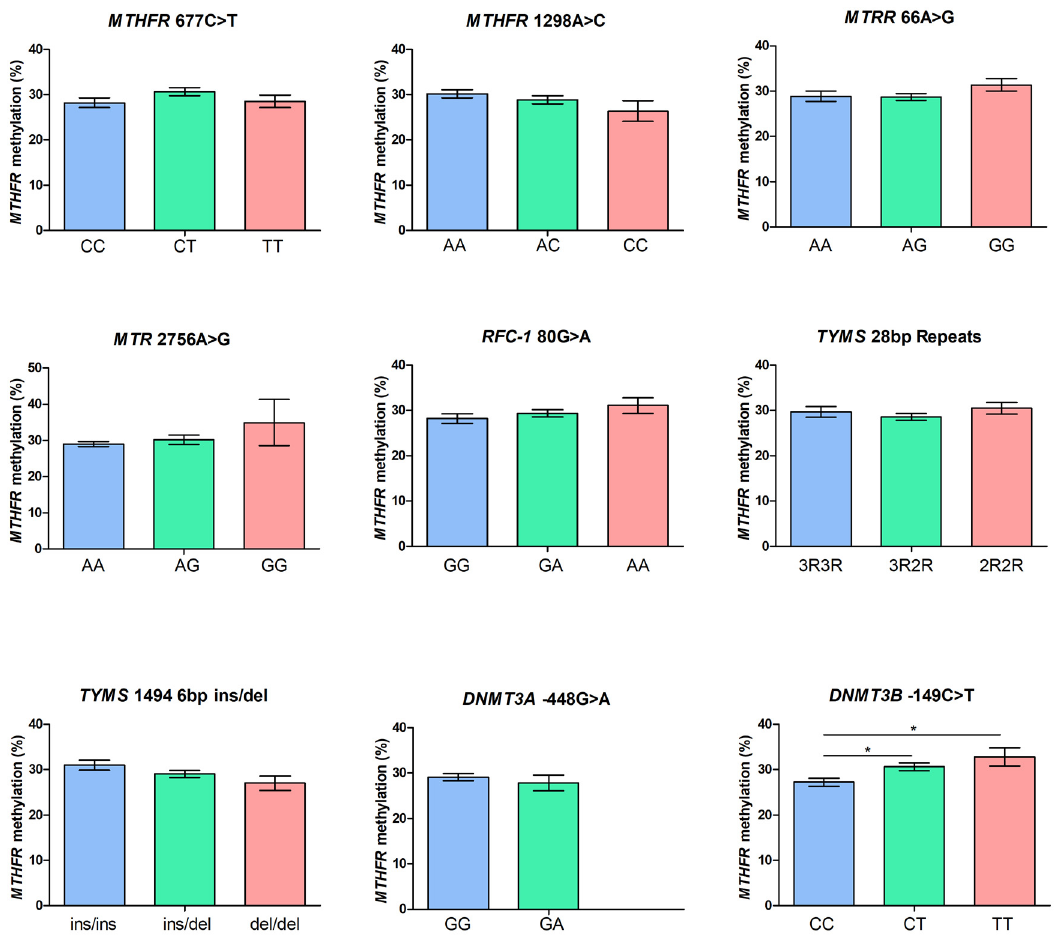
Figure 2. Correlation between one-carbon metabolism gene polymorphisms and MTHFR methylation levels. Data are expressed as means ± SEM. *Denotes a statistically significant difference after post-hoc Bonferroni’s correction for multiple testing ( p <0.05).